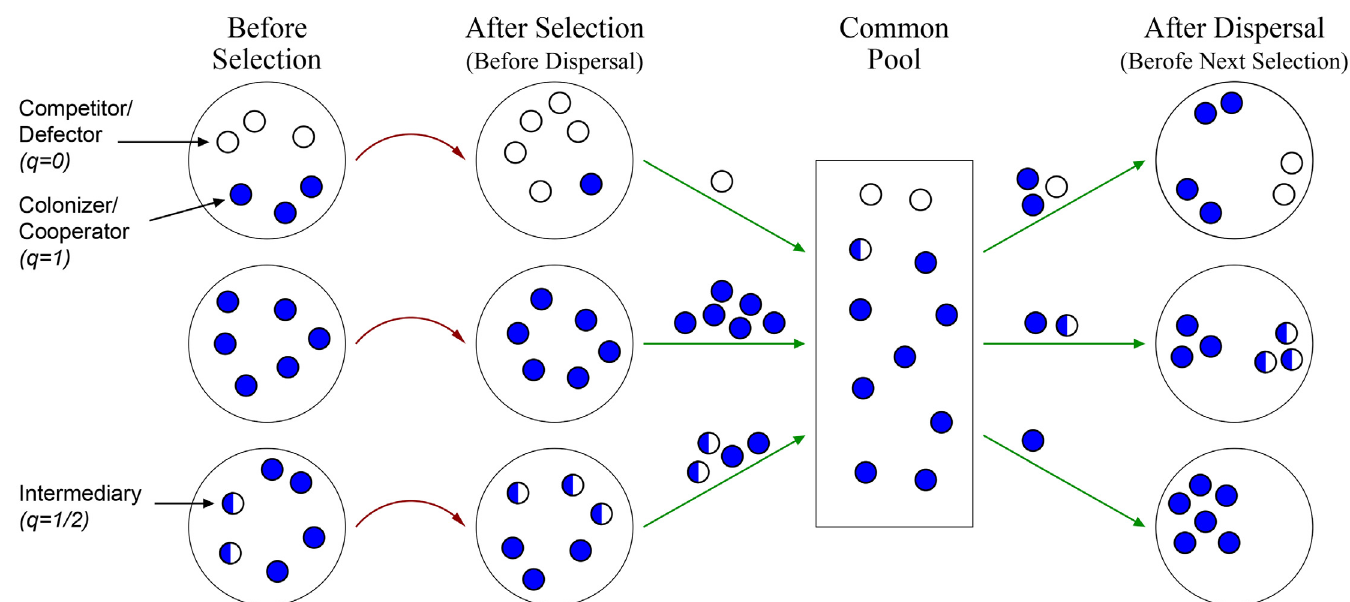
Fig 1. Our model comprises local selection and global dispersal. A single dynamical cycle is illustrated for 3 patches and 3 trait magnitudes ( q = 0.1, q = 1/2, q = 1). At the selection stage (red curved arrows), deterministic selection that favors competitors with lower q takes place in each patch separately according to the replicator dynamics (Eq (1)), where the greater the disruptive selection strength, s , the greater the relative abundances of advantageous competitors become. At the dispersal stage (green straight arrows), the probability of each individual to join the common pool increases with the average q in its patch (or with its own q in an alternative model variation). Finally, each individual has a constant probability ( * α ) to become a seeder and establish a clade in a randomly-picked patch. In our simulations, we consider a continuum of possible trait values, 0 (cid:3) q (cid:3) 1; large patch populations at selection stage; and infinitely many patches, which determines deterministic dynamics of trait abundances Eq